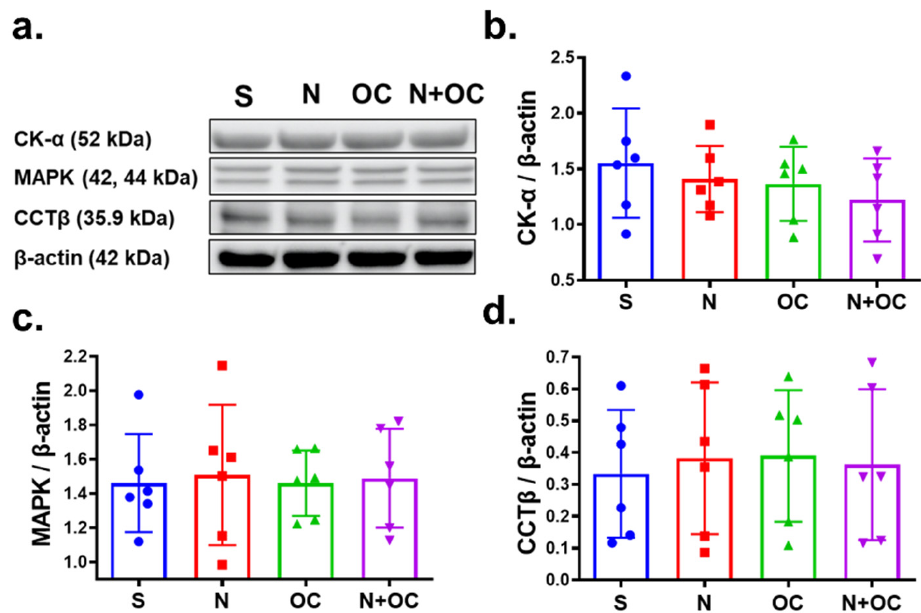
Figure 8. Immunoblotting of key enzymes involved in PC metabolism. ( a ) Immunoblots show steady-state protein levels of choline kinase α (CK α ), mitogen-activated protein kinase (MAPK), and phosphocholine cytidylyltransferase β (CCT β ) in the cortex of saline-, N-, OC-, and N + OC-exposed rats. β -actin was the loading control. ( b – d ) Western blot analysis demonstrates no significant changes in steady-state protein levels for CK α , MAPK, and CCT β .